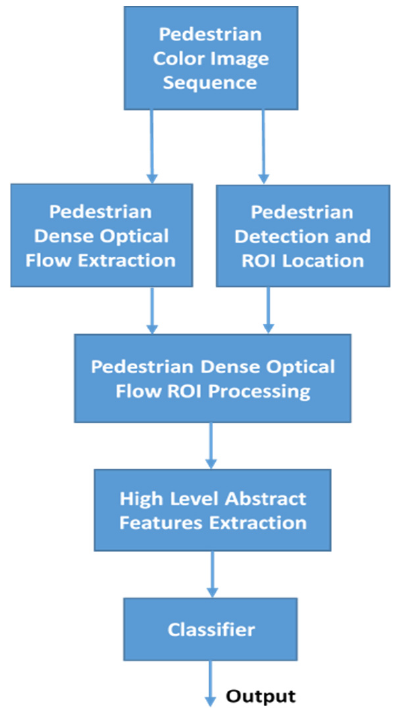
Figure 1. System Figure 1. System flowchart.